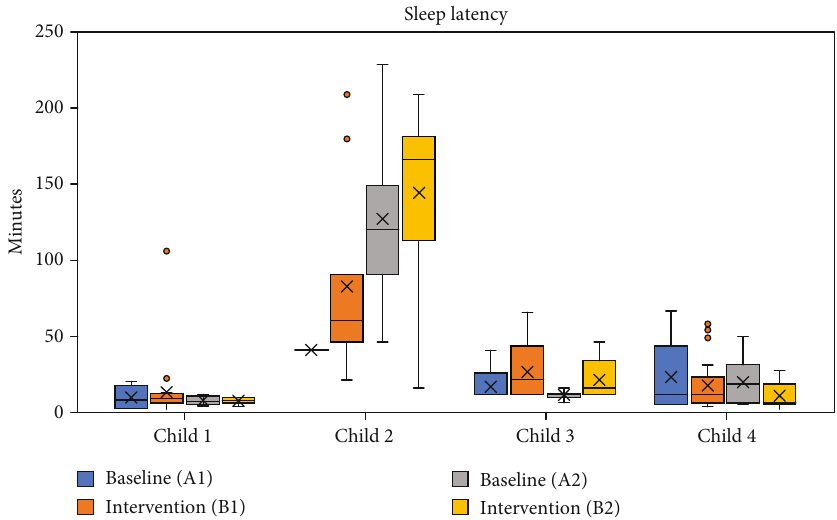
Figure 1: Sleep latency. Note . Child 2 and 3 latency is the time to fall asleep reported by parents. Child 1 and 4 latency is the time from light to deep sleep reported by the Garmin. Child 1 has 12 days of missing latency data. Only one latency data point was available for Child 2 during A1 with a total of 17 days of missing latency data. Child 3 has 6 days of missing latency data. Child 4 has 2 days of missing latency data. For bar graph analysis, missing data was